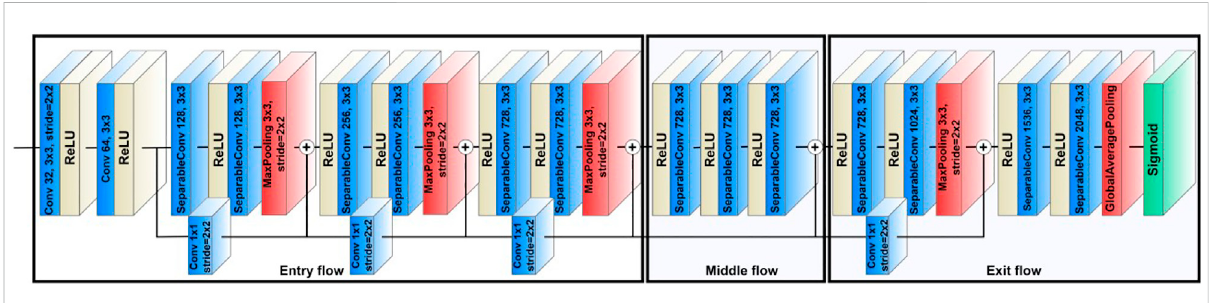
FIGURE 3 The architectures of Xception model (Conv stands for convolutional